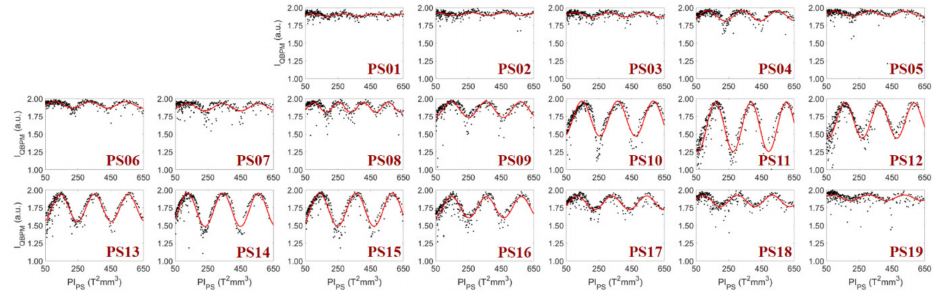
Figure 6. Measured FEL intensity with the QBPM and its sine curve fitting (red line) as a function of the phase integral for all phase shifters from PS01 to PS19. PS01 is located between Und01 (the first undulator in the hard X-ray FEL line) and